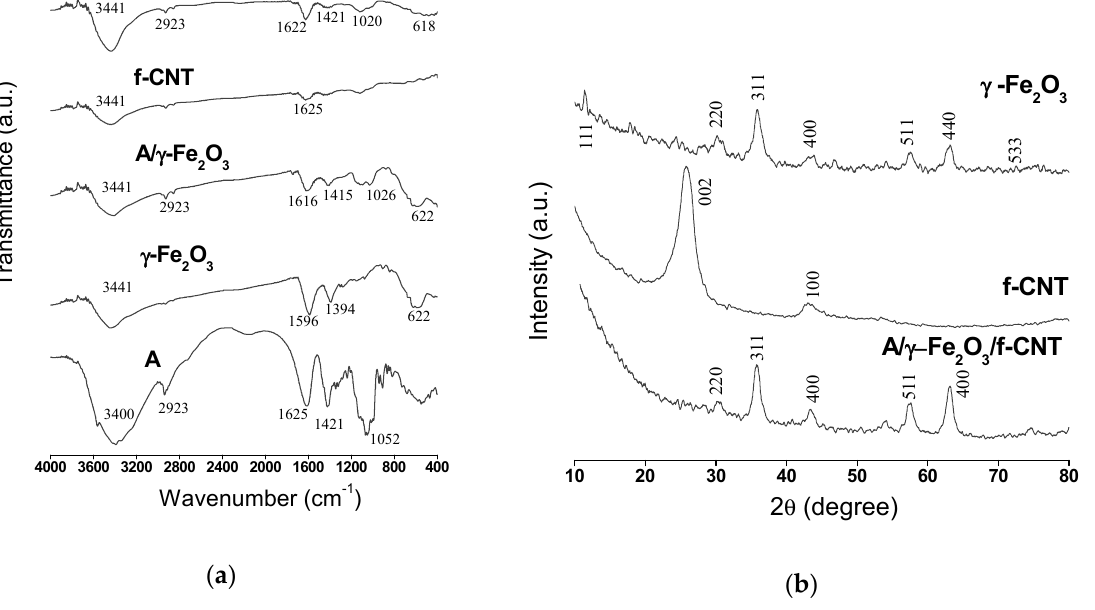
Figure 2. ( a ) FTIR spectra of alginate (A), f-CNT, γ -Fe 2 O 3 particles, A / γ -Fe 2 O 3 and A / γ -Fe 2 O 3 / f-CNT beads; ( b ) XRD patterns of f-CNT, γ -Fe 2 O 3 particles and A / γ -Fe 2 O 3 / f-CNT beads.